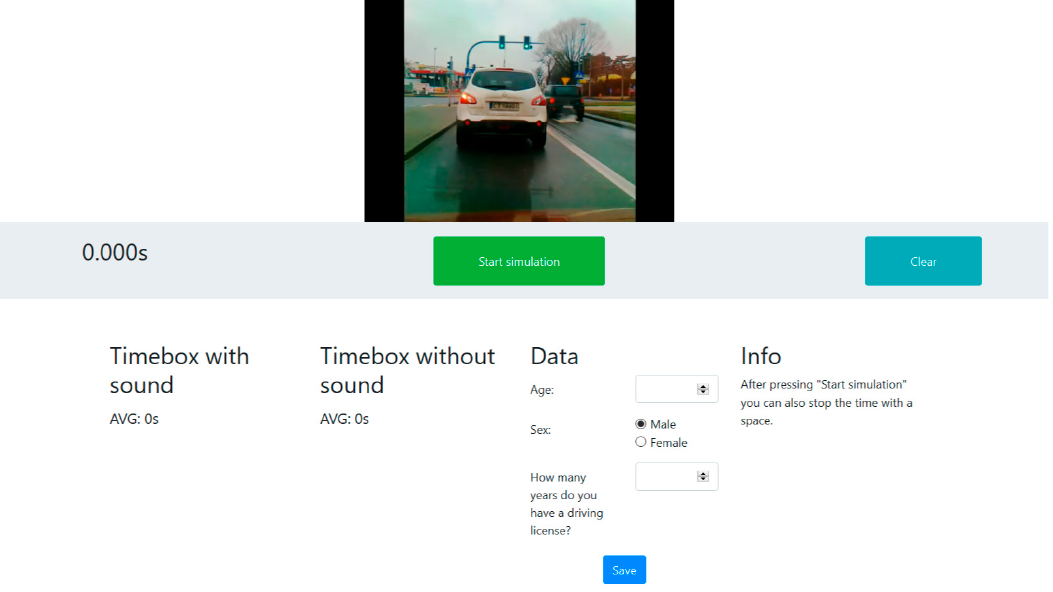
Figure 7. A fragment of the website created to measure the reaction time.